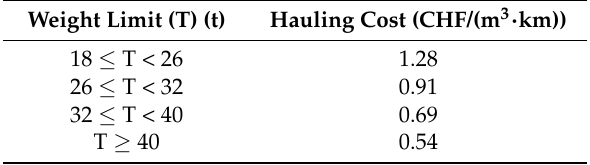
Table 4. Hauling cost as a function of weight limit when hauling timber over a single